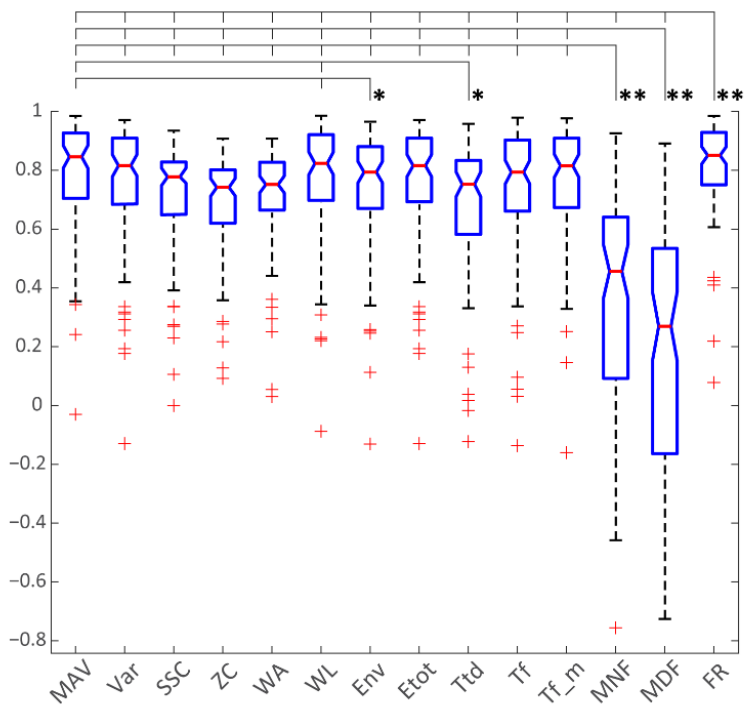
Figure 5. Cross-correlation between the algorithms and joint forces (ground truth). These data comprise all subjects and all joint force estimates (except for the channels labeled as “poor”). * p < 0.05, ** p < 0.01. Table 4. Statistical significance between algorithms for both RMSE and cross-correlation. Green indicates statistically significant difference ( p < 0.05; Bonferroni-corrected) for the RMSE metric and orange indi- cates significant difference ( p < 0.05; Bonferroni-corrected) for the cross-correlation metric. The cases of significant differences for both metrics are marked with * on the cross-correlation part of the table. Grey indicates diagonal fields.